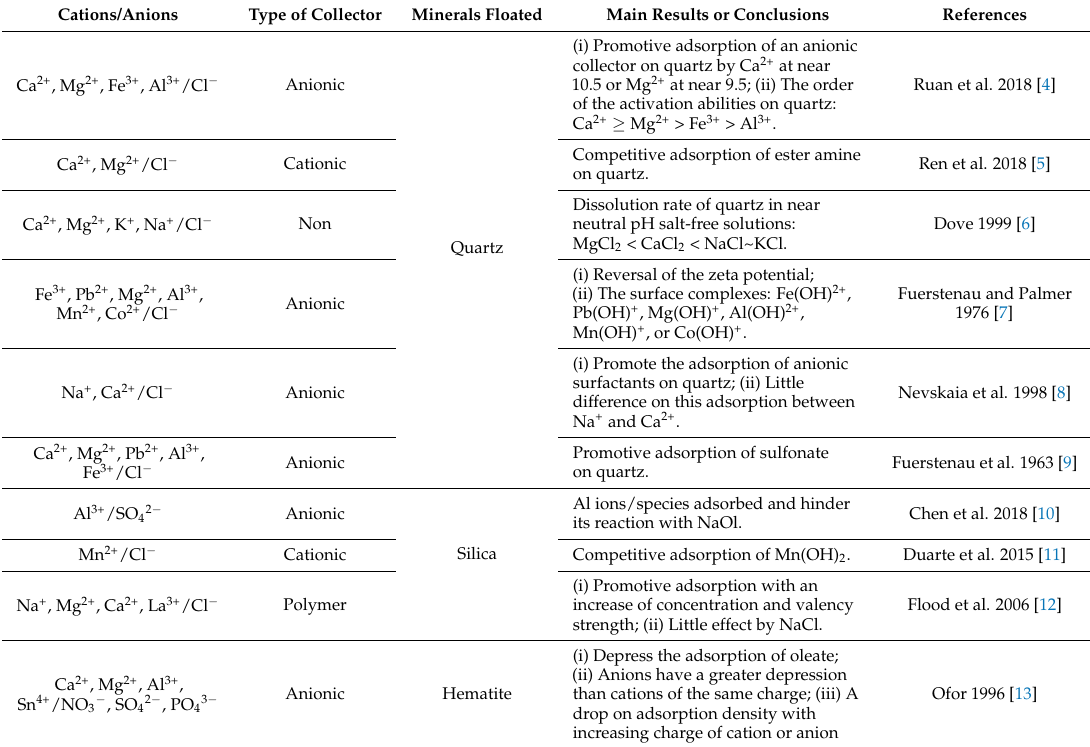
Table 1. Some literature about the effects of cations/anions in the water on the reverse/direct flotation of iron oxides